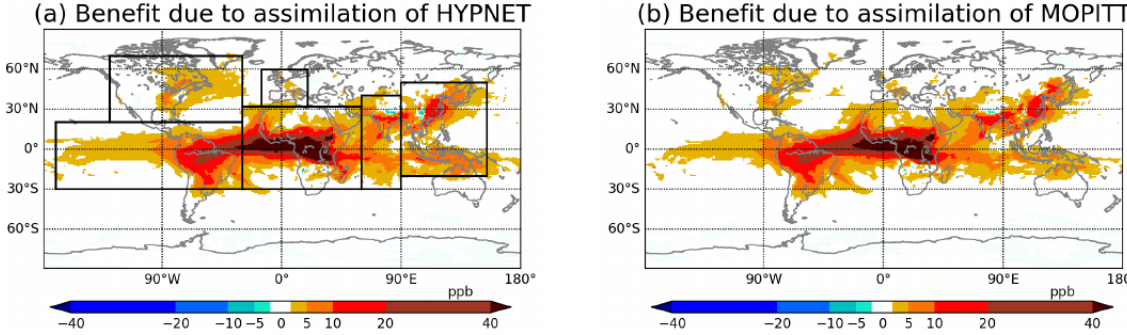
Figure 9. Column (0–5km) mean benefit averaged from 10 January 2015 at 18:00:00UTC to 28 February 2015 at 00:00:00UTC. In panel (a) , the marked boxes show the domains of North America, South America, Europe, Africa, South Asia and East Asia. These domains are used in Fig. 11. Note that all of the domains contain both ocean and land. The South American domain includes a large part of the Pacific Ocean.